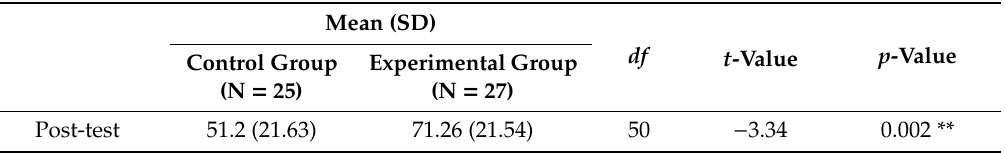
Table 6. Learning e ff ectiveness of test subjects from playing an augmented reality (AR)-based board